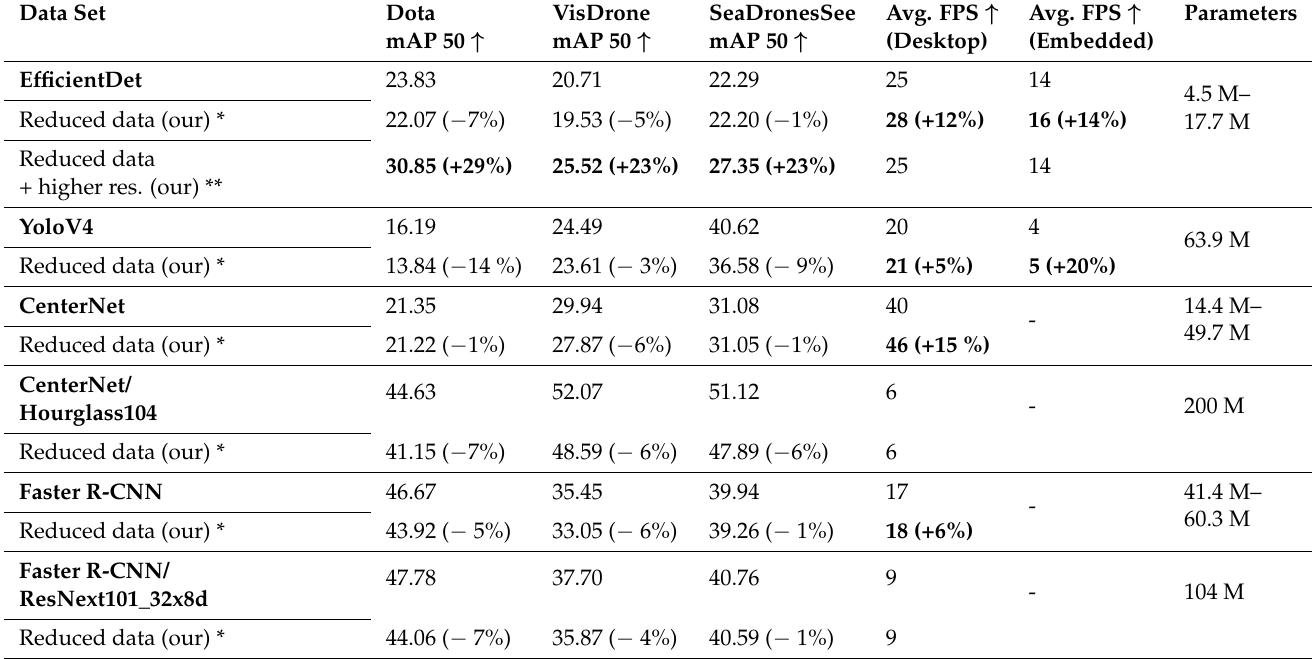
Table 3. Application of the optimized parameter configuration in a desktop and an embedded environment: The mean Average Precision (mAP) are presented for the data sets and the models. For each model, at least two configurations are given (baseline and optimized pipeline). Frames per second (FPS) indicate the inference speed of each model. In the last column, the number of trainable parameters is given. The percentages in the parentheses indicate the change regarding the